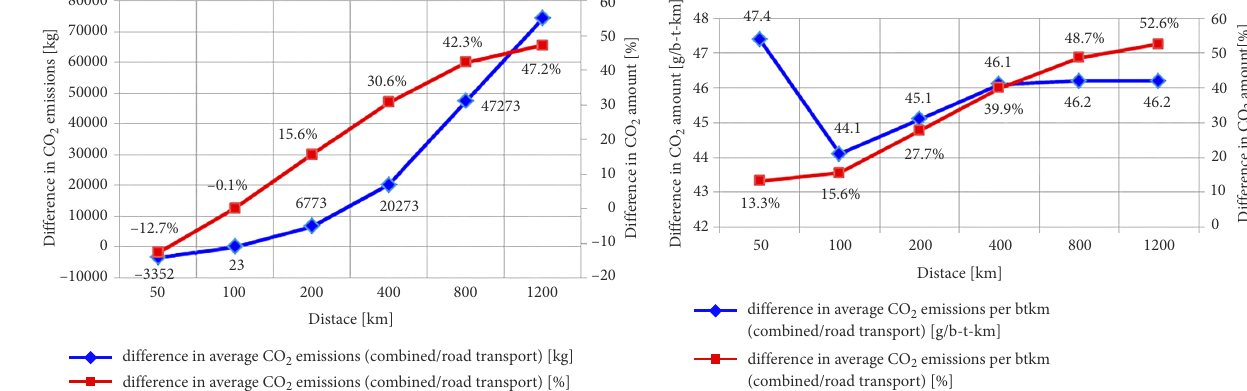
Figure 5. Differences in the CO